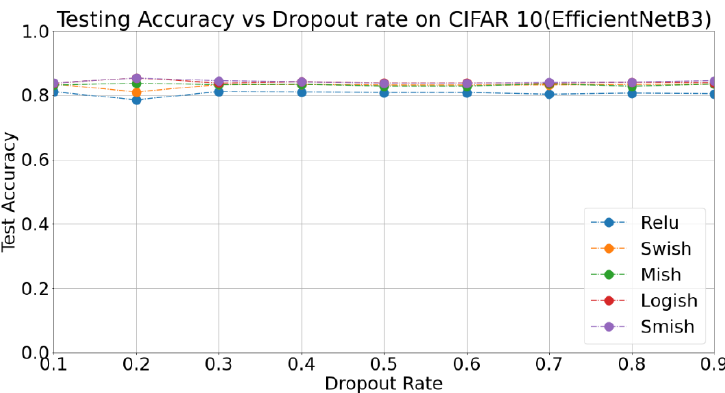
Figure 7. Test accuracy vs. dropout rate.